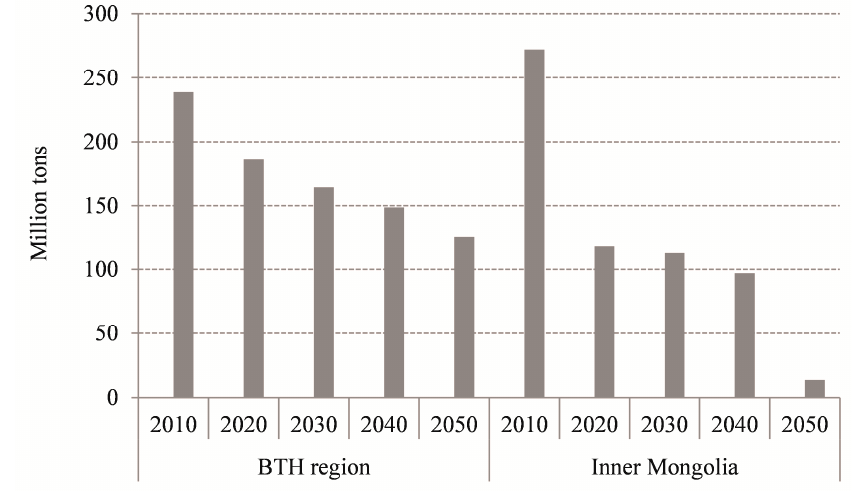
Figure 5. CO 2 emissions from power generation between 2010 and 2050 for BTH and Inner Mongolia.